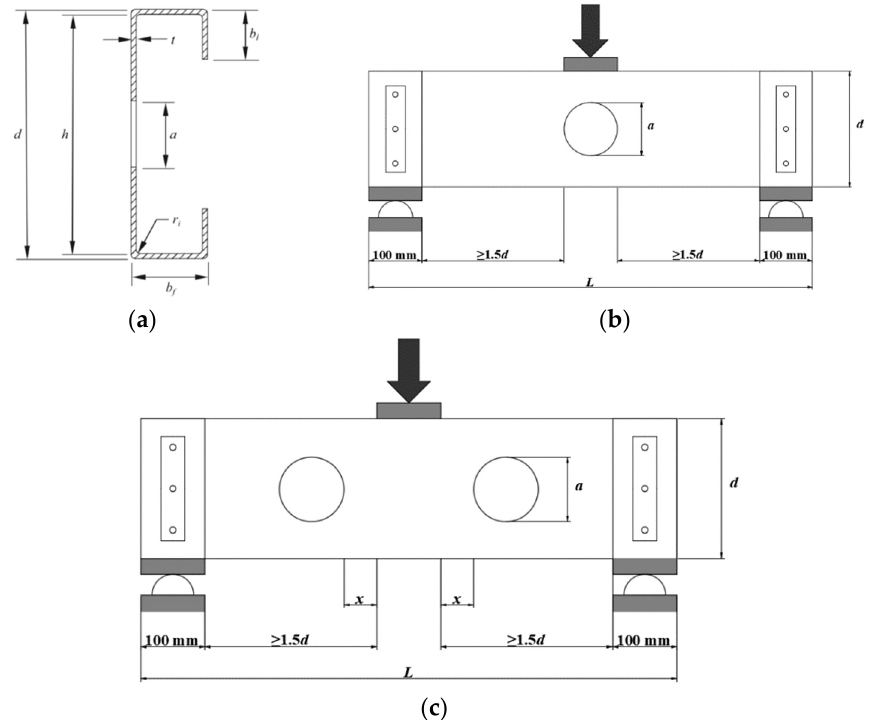
Figure 1. Definition of symbols and loading cases: ( a ) Section dimensions; ( b ) sections with centered holes from the bearing plate under IOF; ( c ) sections with offset holes from the bearing plate under